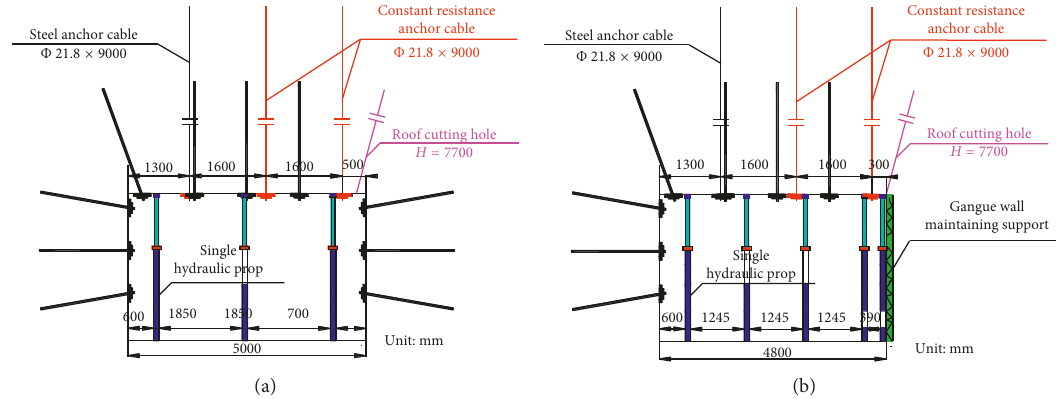
Figure 9: Temporary support design of the 8304 working face: (a) advance temporary support and (b) lagging temporary support.